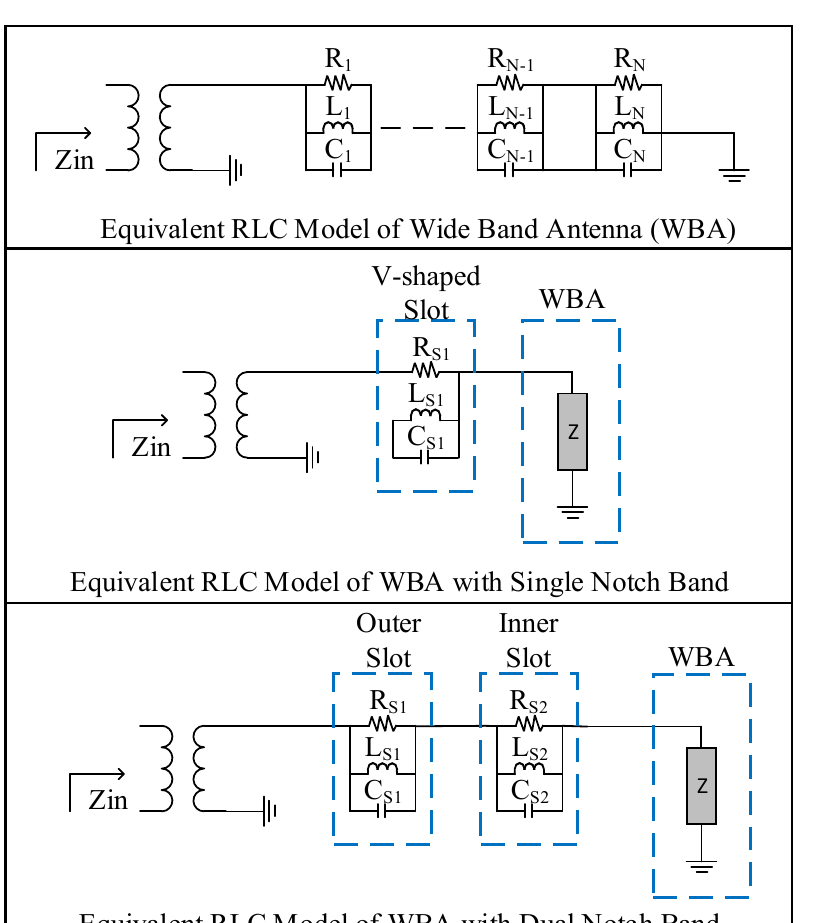
where E was assumed to be the finite length of a wire of rectangular cross-section equals to the notch area, D is the length approximately equals to the cross-section of the slot, and θ is the angle between the legs of the V-shaped slot.